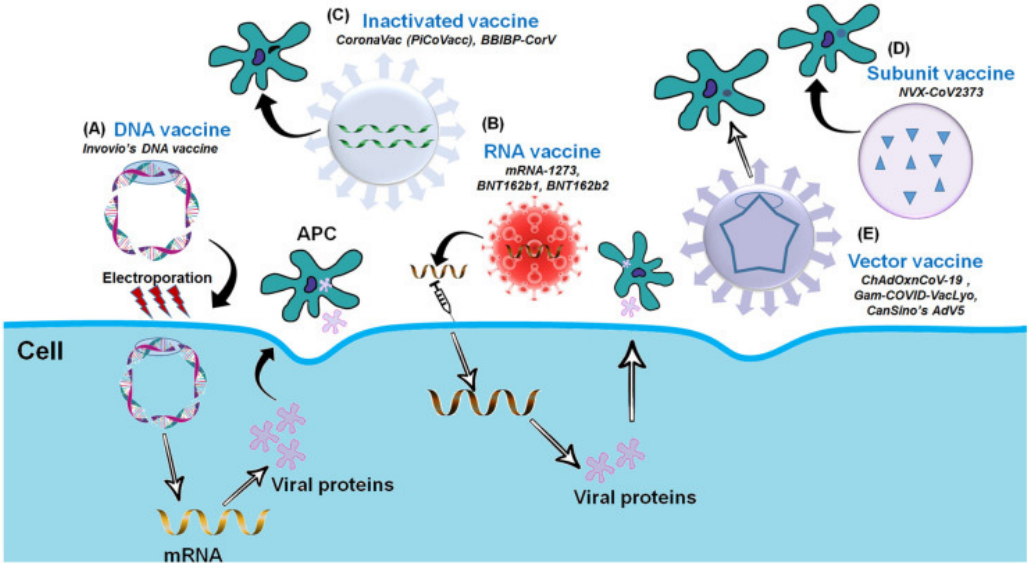
Figure 3. The Platform for COVID-19 Vaccine (adapted with permission from Ashraf et al., 2021) [27]. Platforms for the COVID-19 Vaccine Development. ( A ) DNA vaccine: Plasmid DNA expressing S protein. ( B ) RNA vaccine: mRNA-based (RBD of S-protein). ( C ) Inactivated vaccine: Inactivated whole SARS-CoV-2. ( D ) Subunit vaccine: Recombinant S-protein and ( E ) Vector-based vaccine: Replicating or Non-replicating viral vector used for the delivery and expression of S protein.